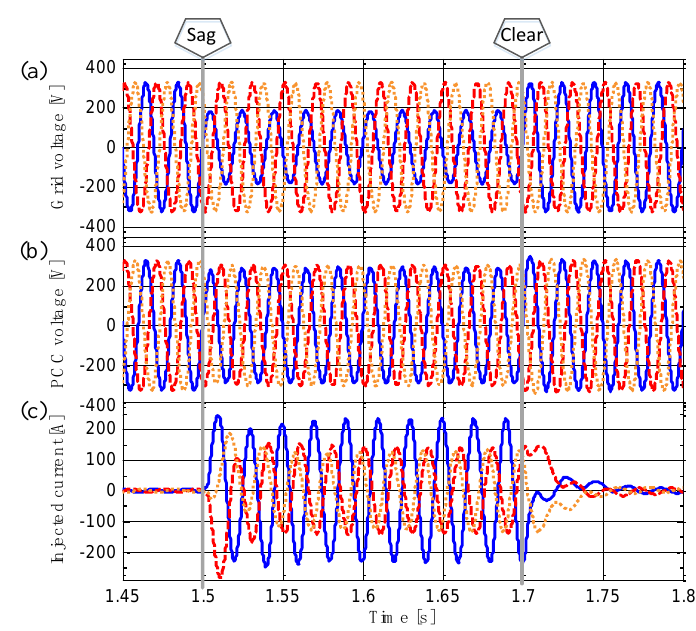
Figure 6. Response of the SPC-based power converter under an asymmetrical grid fault when A pos = 1, A neg = 10 A pos : ( a ) grid voltage; ( b ) point of common coupling (PCC) voltage; and ( c ) current injected by the converter.